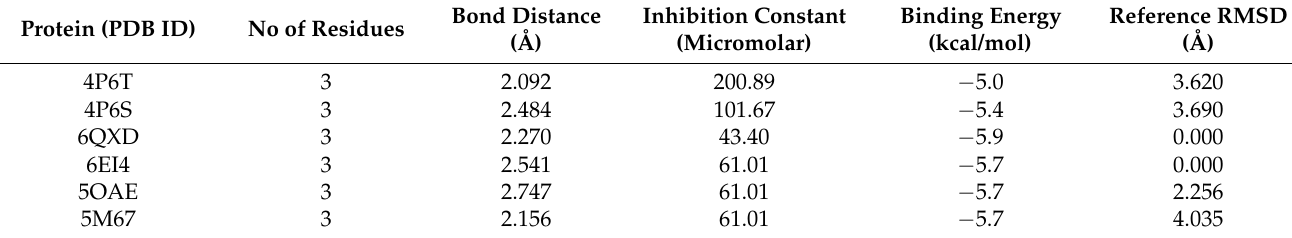
Table 5. Hydrogen bonding and molecular docking score of 5-HMU with protein targets.